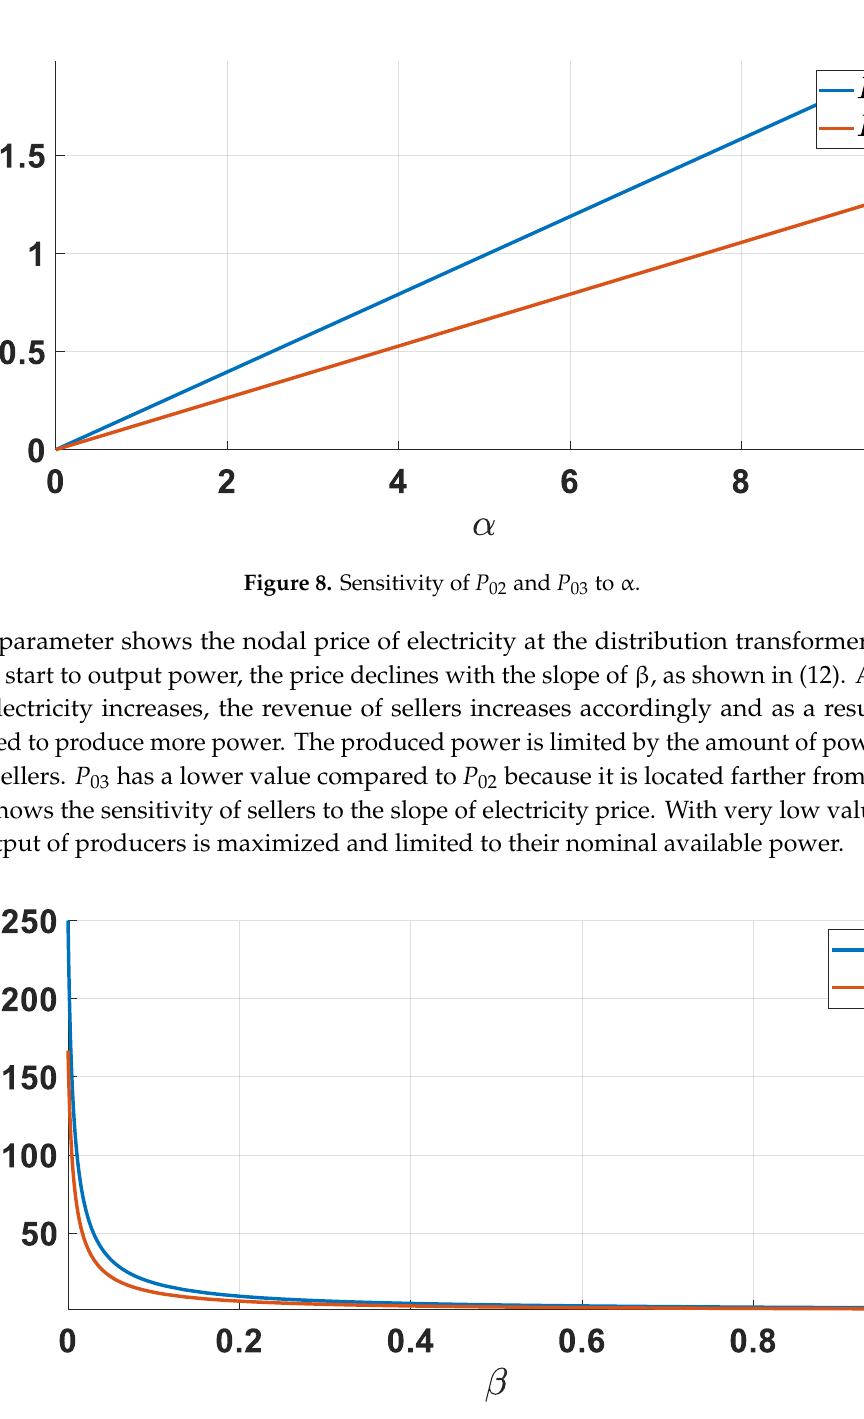
Figure 9. Sensitivity of 𝑃 02 and 𝑃 03 to β .